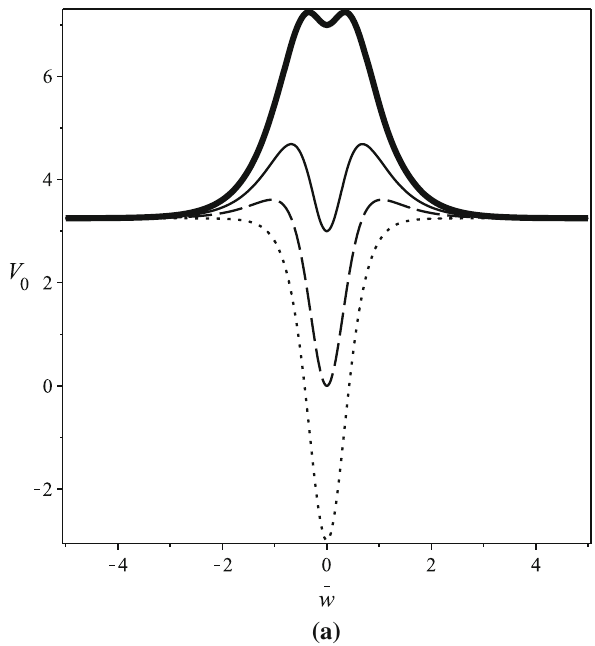
Fig. 1 The profile of the potential V 0 (w) for M 2 = 1 . 5 (dashed line), M 2 M 2 Elko line) and s, H,